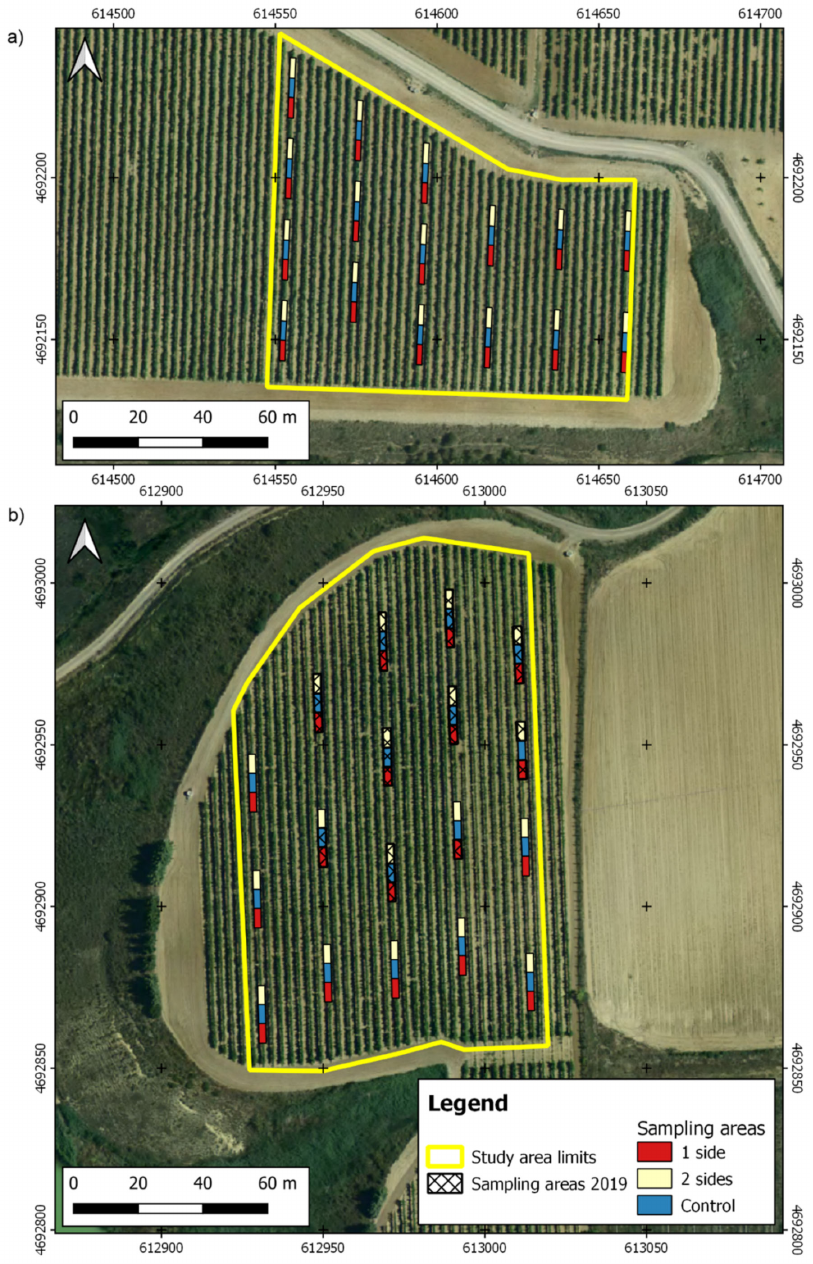
Figure 1. Maps of the study sites and the sampling points: ( a ) field with Garnacha variety; ( b ) field with Graciano variety. Coordinate system: WGS84